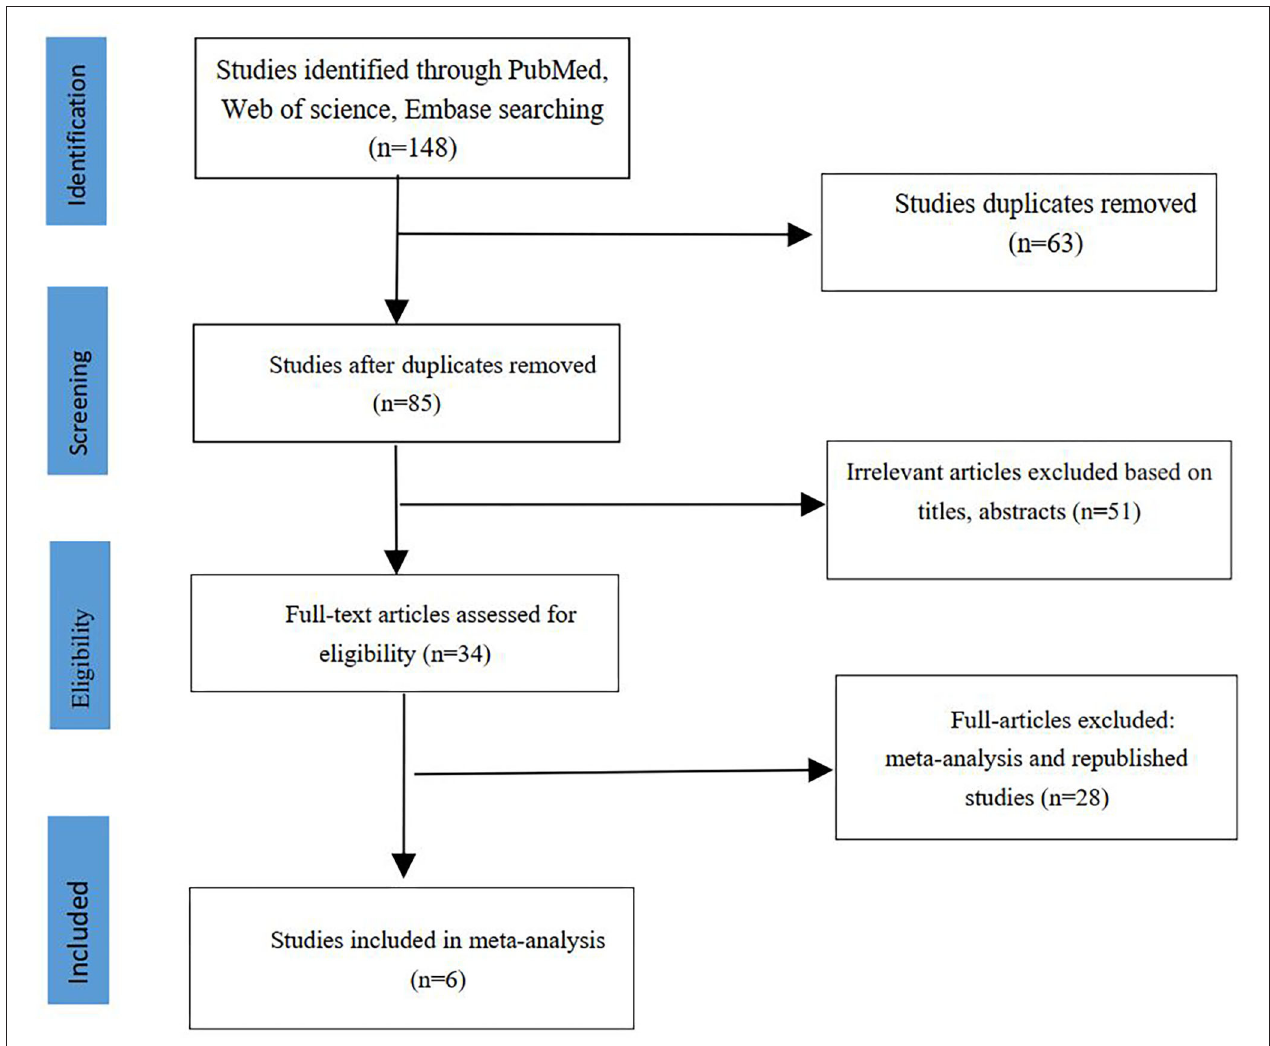
FIGURE 1 | The flowchart showing study search and selection process.